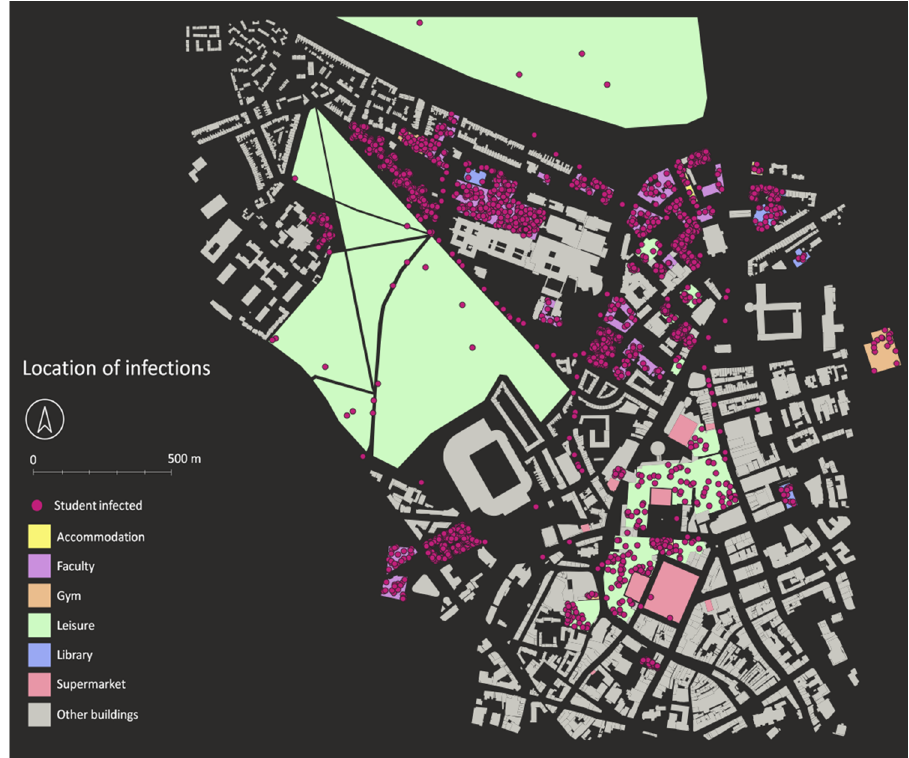
Figure 10. Map showing the locations where students were infected during the outbreak. Contains Ordnance Survey data © Crown copyright and database right 2020. The attribute table of each described output file is shown in Appendix